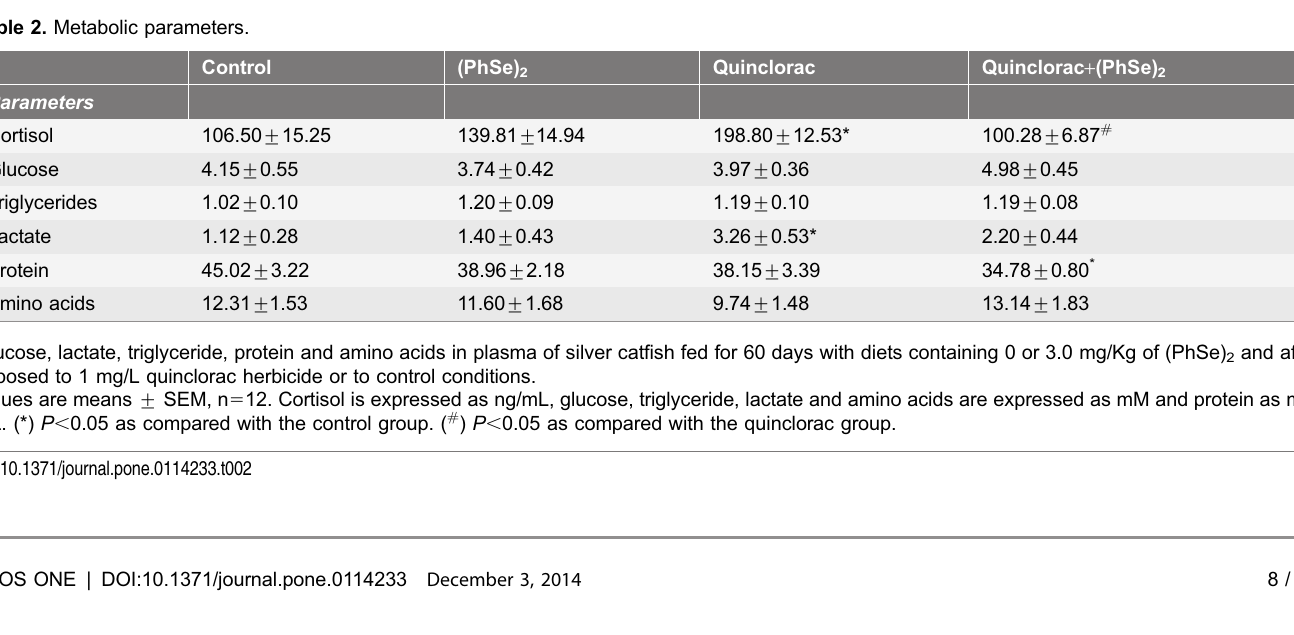
The NPSH and ascorbic acid levels decreased in silver catfish exposed to quinclorac when compared to control group (Figure 1C and 1D). Treatment with (PhSe) per se caused a significant increase in NPSH levels and did not change the 2 prevented the decrease on NPSH ascorbic acid levels (Figure 1C and 1D). (PhSe) 2 and ascorbic acid levels caused by quinclorac exposure (Figure 1C and 1D). group showed an increased ascorbic acid Furthermore, the quinclorac + (PhSe) 2 levels as compared to control (Figure 1D).